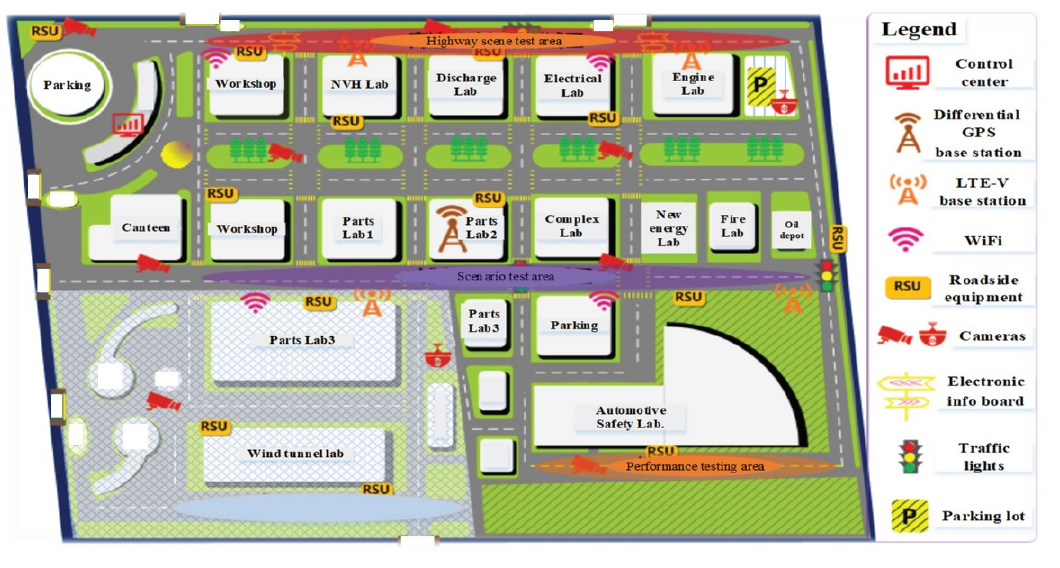
Figure 9. Experimental Area.